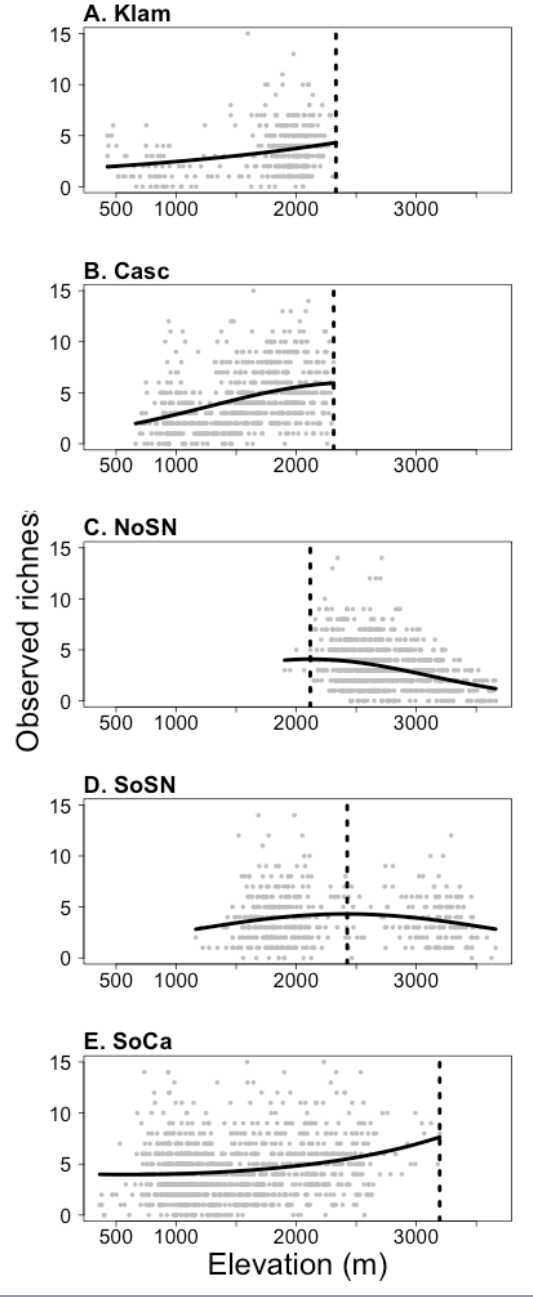
Fig. 3 . Relationships of observed avian richness with elevation, by Californian region of the Pacific Crest Trail. Elevation trends of richness (solid black lines) were modeled for each region separately with the elevation at which richness peaks (dotted black lines) were extracted from these models. Klam: Klamath Mountains, Casc: southern Cascade Range, NoSN: northern Sierra Nevada, SoSN: southern Sierra Nevada, SoCa: southern California mountains.